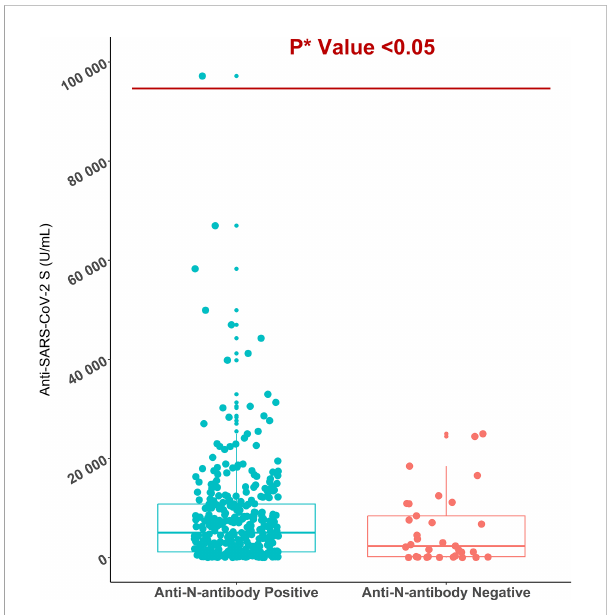
FIGURE 2 Anti-SARS-CoV-2 S antibody titers in anti-SARS-CoV-2 N antibody positive (n=349) and negative migrant workers (n=33). *P value is generated by Poisson regression model and the model was adjusted for age, vaccine types, and time since last